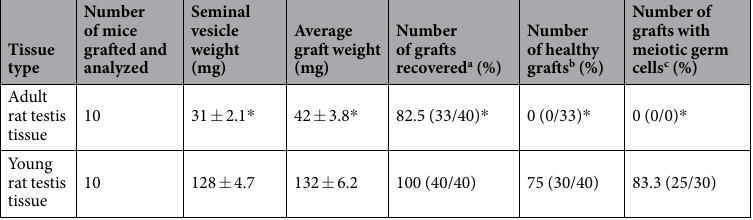
Table 1. Experimental graft data for testis of immature and adult rat donors xenografted and collected 8 wk post grafting. a Total xenografts removed divided by the total number of xenografts grafted. b Percentage of recovered xenografts with intact seminiferous tubules. c Percentage of recovered xenografts with pachytene-stage spermatocytes. * Significantly different within the column (P <